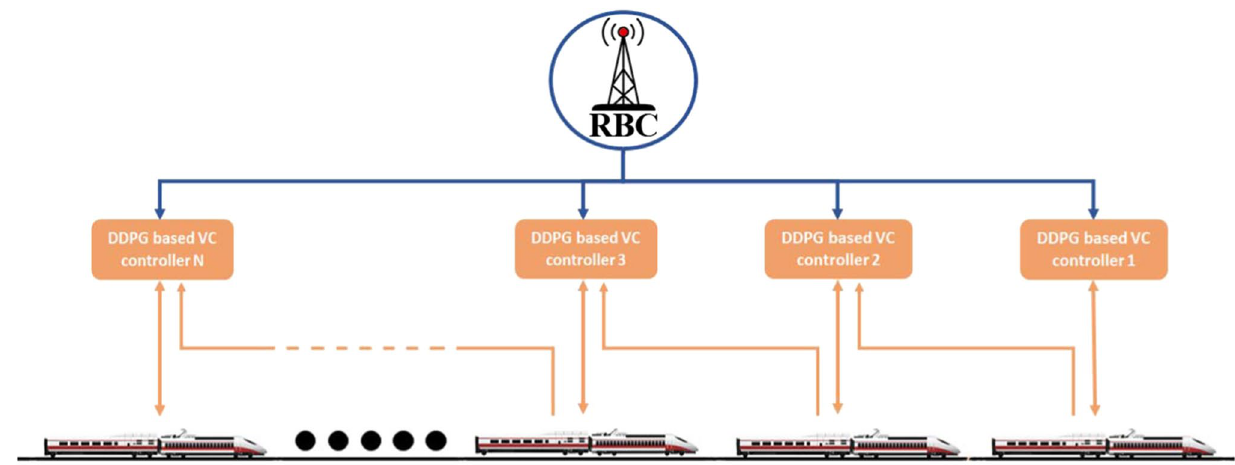
Fig. 3 Conceptual view of a decentralised DDPG-based approach for VCTS, where the blue lines represent the T2I network and the orange lines correspond to the T2T communication